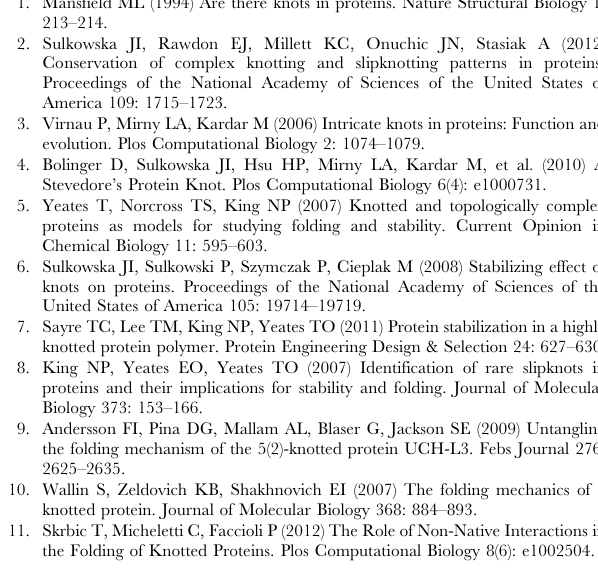
Figure S1 Comparison of the folding rates in the surface- tethered setups and in the point-tethered setups. (TIFF) Figure S2 Mean number of established non-native contacts as a function of the fraction of established native contacts, Q . (A) for the knotted protein and (B) for the unknotted one. To compute these curves we have extracted the relevant data from the set of folding trajectories that were used to evaluate the folding rate (Figure 5). Essentially, we grouped the conformations sampled by the protein in the 2000 MC runs according to their fraction of native contacts, and computed the mean averaged number of non-native contacts in each conformational ensemble. The bump developing from Q , 0.75–0.9 indicates that surface-tethered proteins undergo structural re-arrangement in highly compact, native-like confor- mations. These conformational excursions occur both in the knotted and unknotted folds, although they appear more significant in the case of the knotted fold. Indeed, the plot for protein U is noisy in the Q range of interest and the number of established non-native contacts is also smaller in that case. Figure S3 Probability map in the dominant cluster of conforma- tions with fraction of native contacts Q= 0.75 populated by the knotted protein when it is linked to the plane by its N-terminus. The probability map shows the mean averaged probability of occurrence of each established contact (native and non-native). Also shown (inset) is cluster’s representative conformation that is knotted. The part of the backbone highlighted in green is the knotted core. Figure S4 Alternative knotting mechanism operating in the bulk. Each conformation with fraction of native contacts Q is the closest to the cluster’s centroid, i.e., the cluster’s representative. The residues colored in orange have at least two of its native contacts formed. In parenthesis we show the ratio between the size of the cluster (its number of conformations) and the initial ensemble from which they were clustered where conformations have fraction of native contacts Q . (TIF)